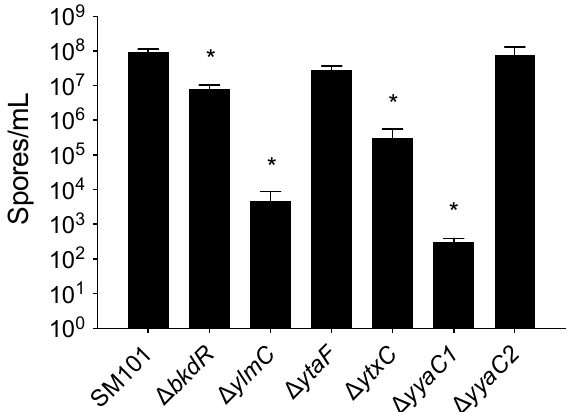
Figure 4. Spore forming efficiency of C. perfringens strains. The spore-forming efficiencies of C. perfringens wild-type SM101 and its mutant derivatives were measured by the direct microscopic count from 12 h culture in DS sporulation medium as described in Material and Methods. Statistical significance was determined by one-way ANOVA followed by Dunnett’s multiple comparison test. The asterisk (*) denotes the significant differences ( p < 0.05) in the values of each isolate compared to the value obtained from the wild-type strain.